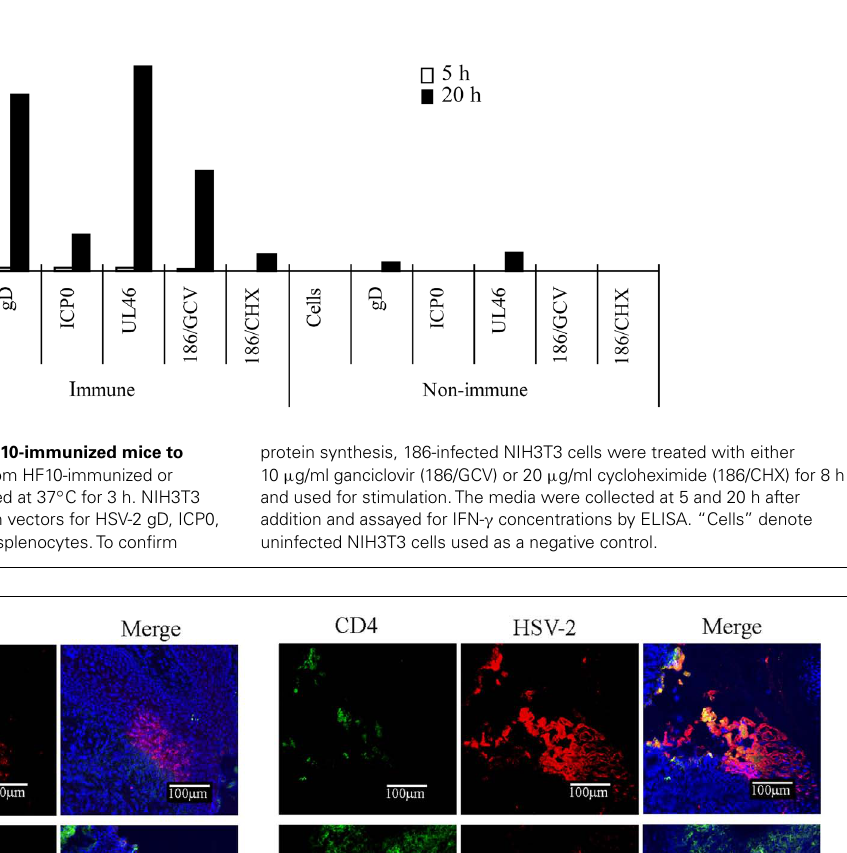
protein synthesis, 186-infected NIH3T3 cells were treated with either 10 μ g/ml ganciclovir (186/GCV) or 20 μ g/ml cycloheximide (186/CHX) for 8 h and used for stimulation.The media were collected at 5 and 20 h after addition and assayed for IFN- γ concentrations by ELISA. “Cells” denote uninfected NIH3T3 cells used as a negative control.